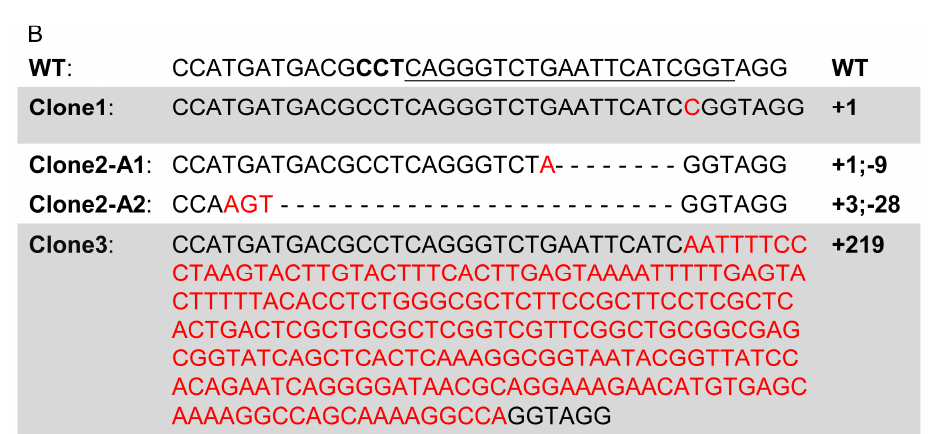
Figure 4. Generation of single cell clones with target gene sall4 edited. pCas9-mU6sgsall4 was transfected into SG3 cells followed by G418 selection. After enrichment, cells were used to form single-cell clones by limiting dilution. Clones formed by a single cell were picked and genomic DNA was extracted from each clone for PCR amplification. ( A ) Heteroduplex assay of DNA templates extracted from three SG3 single-cell clones with different mutations in sall4 . Control lanes were amplicons of genomic DNA from wild-type SG3 cells. ( B ) Sequences of sall4 mutation in single-cell clone 1, 2 and 3. PCR amplicons from DNA templates of clone 1 and clone 3 were directly used for sequencing and PCR amplicon from DNA template of clone 2 was purified and ligated into cloning vector and transformed into E. coli for colony picking, five E. coli single colonies were selected for plasmid extraction and sequencing. The sgRNA target site is indicated by underline and PAM sequence is indicated in bold. Base insertions are shown in red font, and base deletions are shown in dashes.